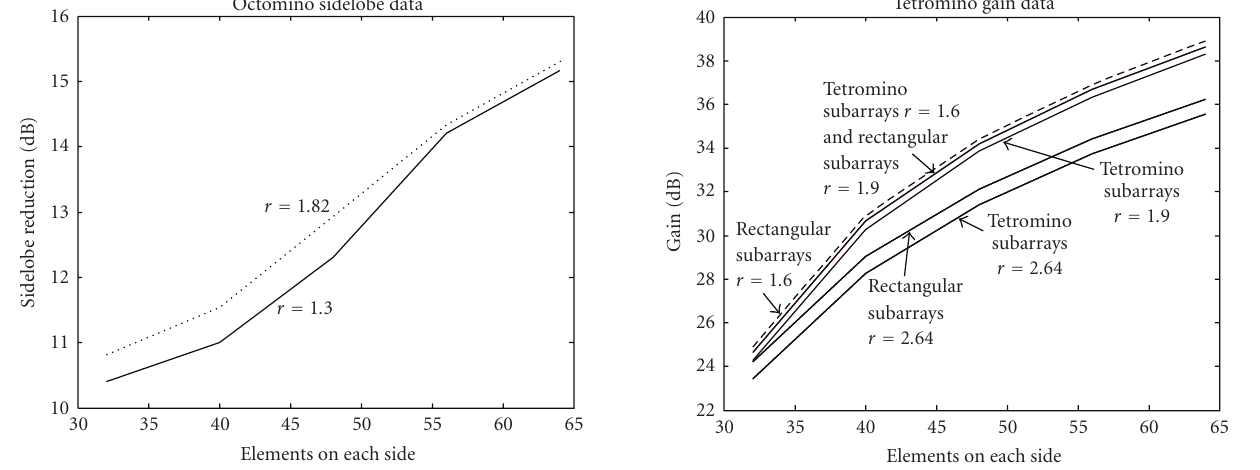
Figure 11: Gain comparison of arrays with time delay at element levels versus time delay at rectangular and L-tetromino subarrays r = f/ f = 1.6, r = 1.9 and r = 2.64 (wide 0